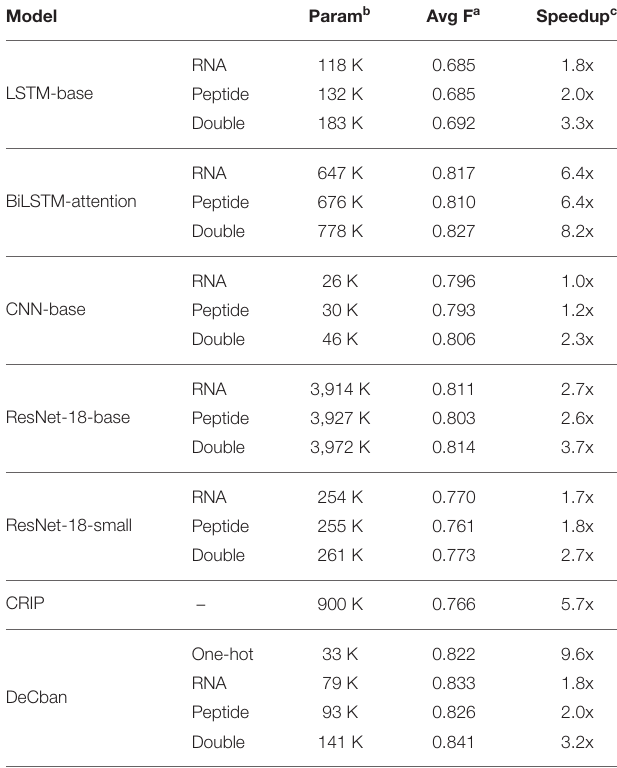
Compared to original RNA embeddings, double embeddings